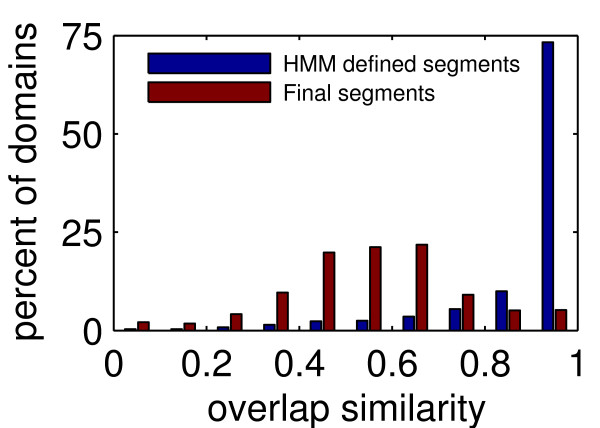
Redundancy of EVEREST domains. To evaluate the extent of redundancy of EVEREST domains, we measure, for each domain, its overlap similarity with the most similar other domain on the same protein. We show a histogram over domains of this score. Blue bars – Allowing each HMM of iteration 3 of EVEREST release 1 to define its own domain family (step 7 of the process). Red bars – Final EVEREST release 1 domains, as defined by a vote of sets of HMMs (step 10 of the process).